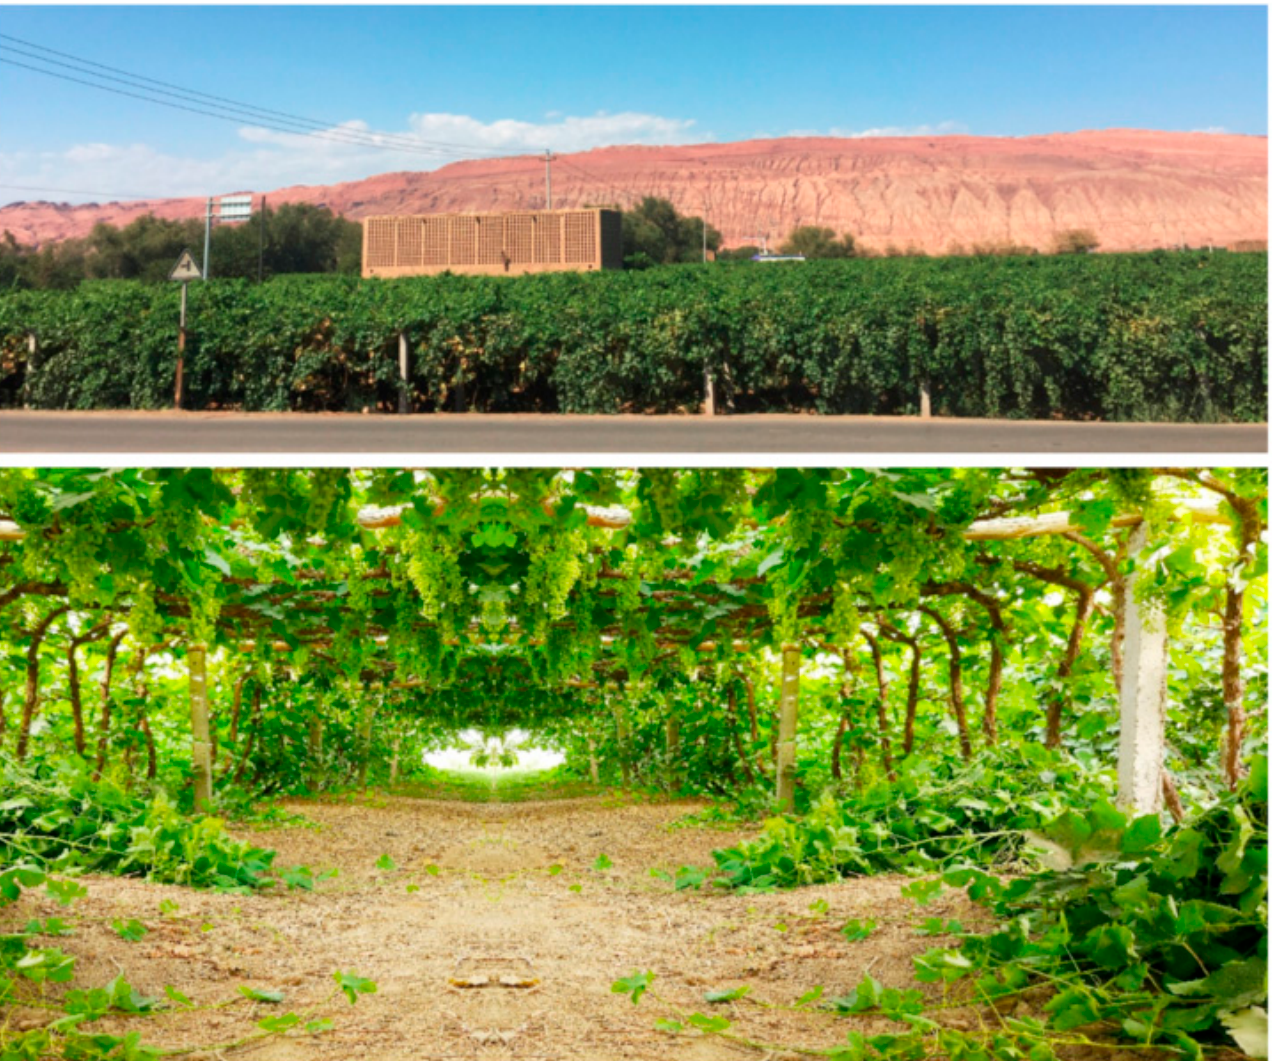
Figure 5. Examples of study areas in Chinese vineyards. Above: the Flaming Mountains, Turpan, Xinjiang Uyghur Autonomous Region. Below: vineyards of the Lukeqin Town, Shanshan Country, Turpan, Xinjiang Uyghur Autonomous Region. Photographs provided by Dr Abdulla Abliz from Xinjiang University, Dr Osmanjan Ilniyaz from Wuhan University. Special thanks to Dr Maierdang Keyimu from the Research Center for Eco-Environmental Sciences, Chinese Academy of Sciences.